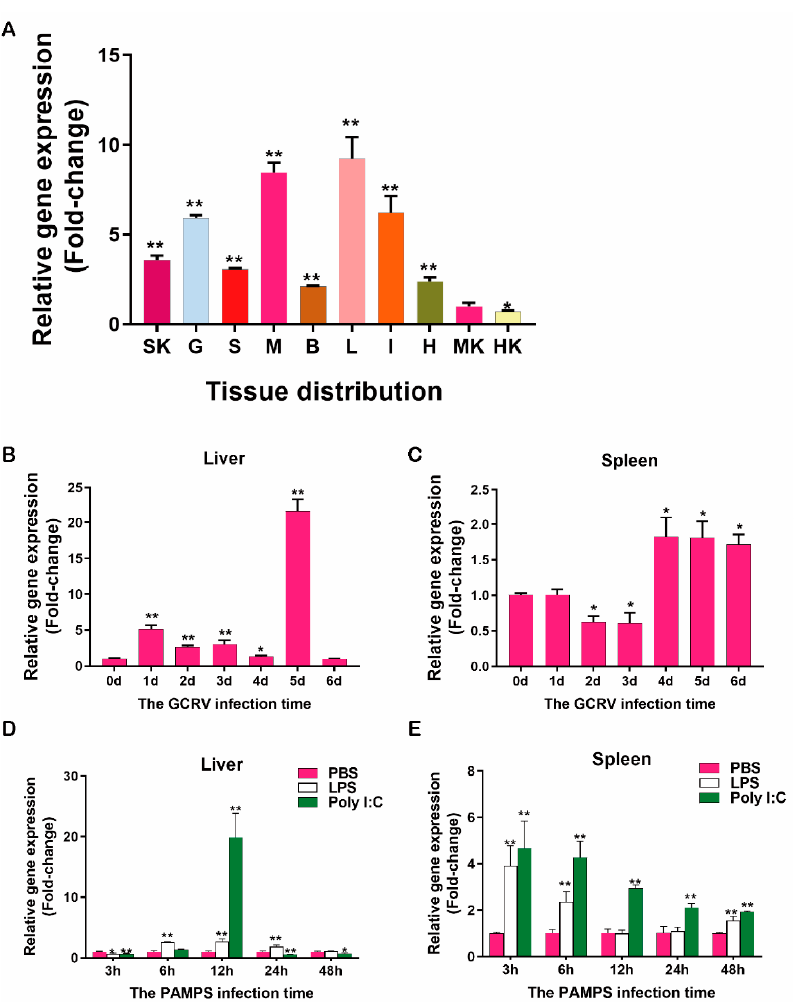
Figure 3. Expression patterns of CiPrx3 . ( A ) Tissue distribution of CiPrx3 . The determined tissues included SK: skin; S: spleen; B: brain; G: gill; L: liver; HK: head kidney; H: heart; MK: middle kidney; M: muscle; and I: intestine ( n = 5). The relative expression is the ratio of gene expression in different tissues relative to that in the middle kidney. ( B , C ) Expression level of CiPrx3 in the liver ( B ) and spleen ( C ) after GCRV infection. The relative expression is the ratio of gene expression after expo- sure to GCRV (1, 2, 3, 4, 5, and 6 days) to that in the control group (0 day) in the same tissue. ( D , E ) Expression pattern of CiPrx3 in the liver ( D ) and spleen ( E ) after PAMP stimulation. The relative expression was calculated as the ratio of the gene expression level in the LPS- and poly (I:C)-treated groups relative to that in the PBS-treated group at the same time point. The β -actin was used as an internal control. All data are given in terms of relative mRNA expression as the mean ± SD. Asterisks represent significant differences (* = p ≤ 0.05, ** = p ≤ 0.01).